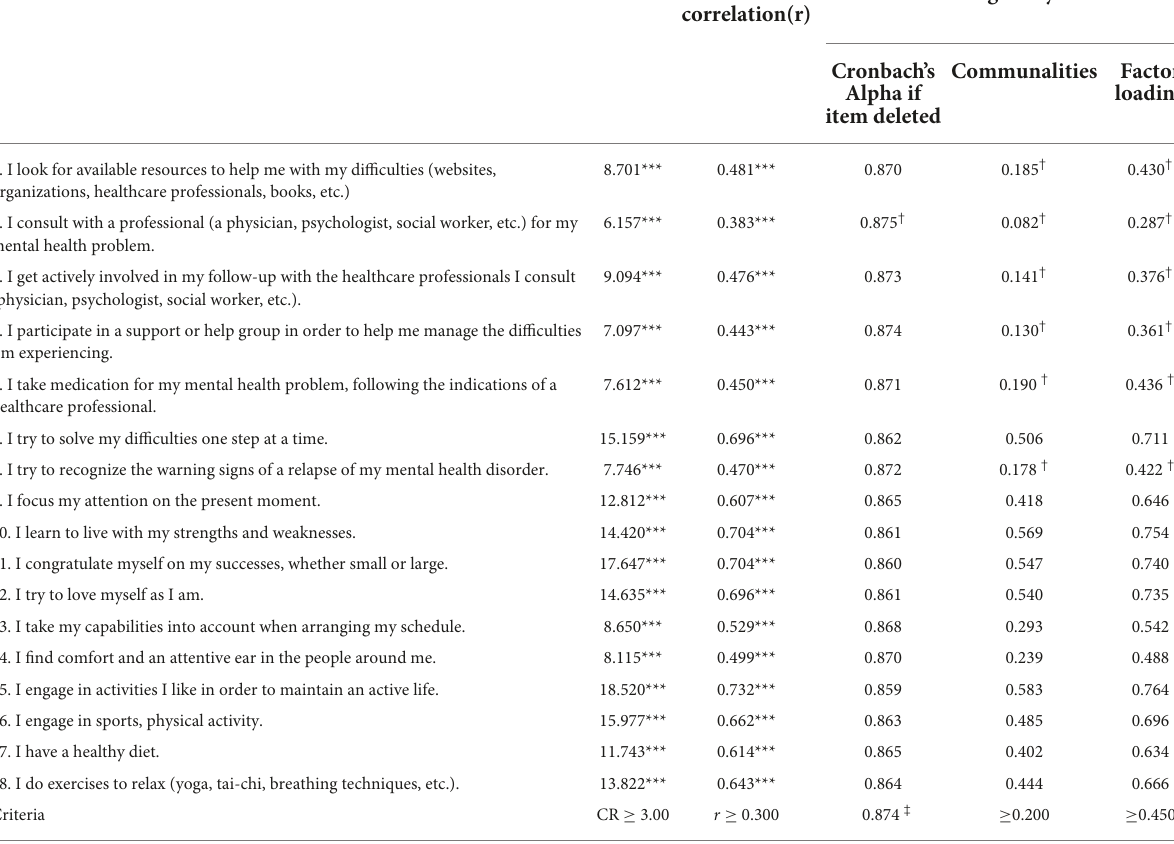
TABLE 2 Item analysis results of the Chinese version of the Mental Health Self-management Questionnaire (MHSQ-C). Item